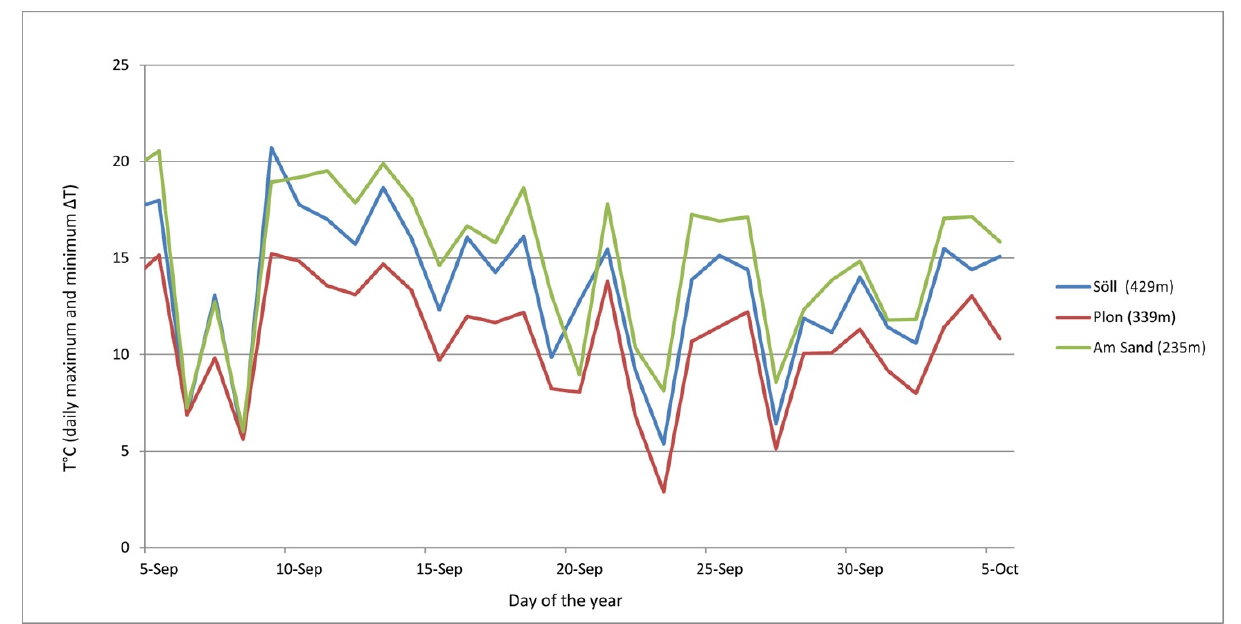
Figure 4. Daily differences between the maximum and minimum temperatures during the con- trolled pre-harvest month. See Figure 1 for the geographical position of the monitoring stations.